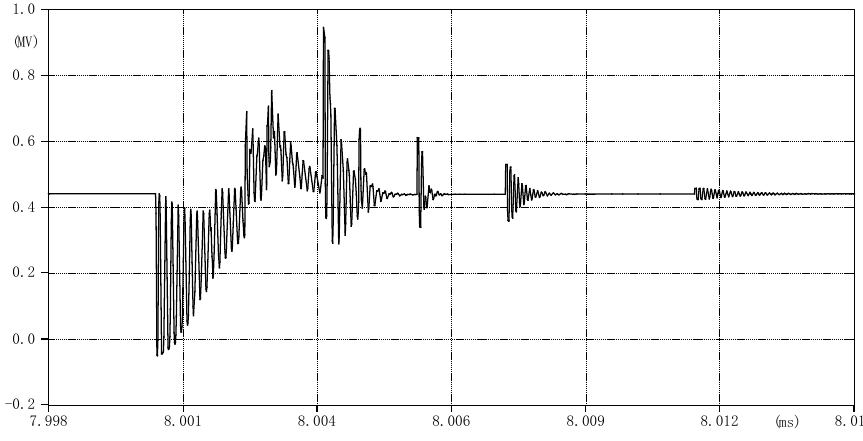
Figure 5. VFTO waveform of power supply